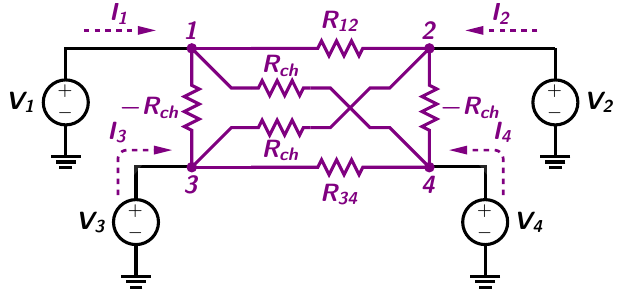
Figure 12. The RN-G